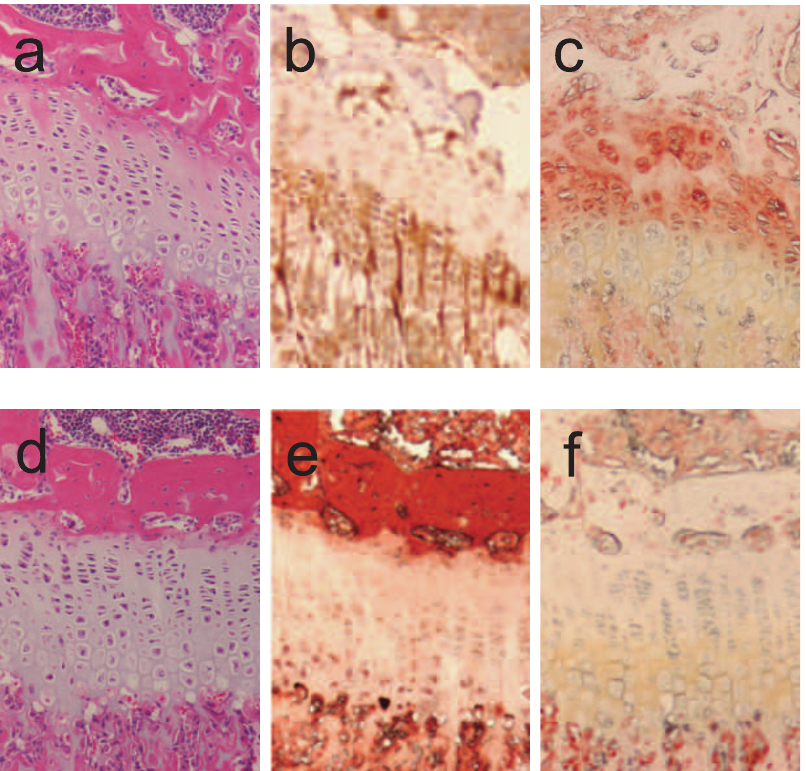
Figure 4. Histological analysis of long bones of TrkB mutants. A, B, and C are stained histological sections from a 4 week old male TrkB loxp/loxp control; D, E and F are from a male TrkB loxp/loxp ;Col2a1-cre littermate. A, D, H&E staining; B, E, ColX immunostaining; C, F, TrkB